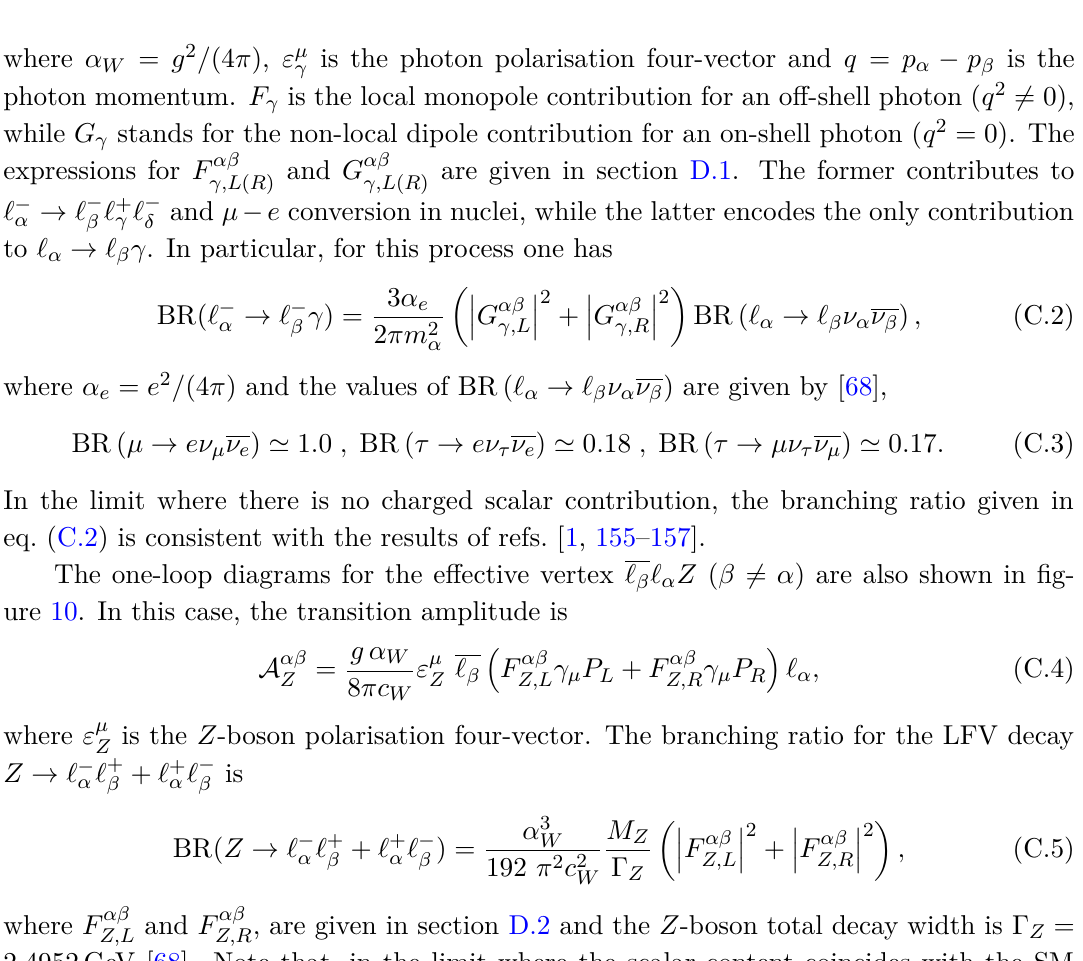
Figure 11 . Generic box diagrams contributing to ‘ − contributions, similar diagrams with G ± and H ± were also included in the calculations. We have also taken into account LNV diagrams (on the right) due to the Majorana character of neutrinos, and crossed diagrams corresponding to the flavour index interchange β ↔ δ